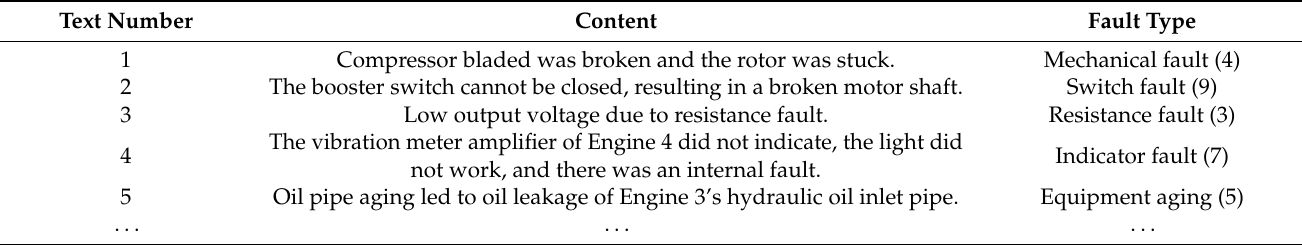
Table 1. Examples of aircraft fault text.